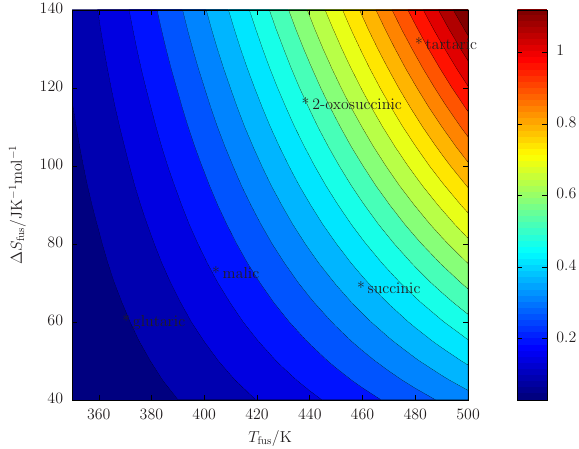
Fig. 1. ω ls (1C p,ls = 0 ) − ω ls (1C p,ls = 1S fus (T fus )) at 298K vs. T fus and 1S fus (T fus ) . The position of some diacids is indicated. figure